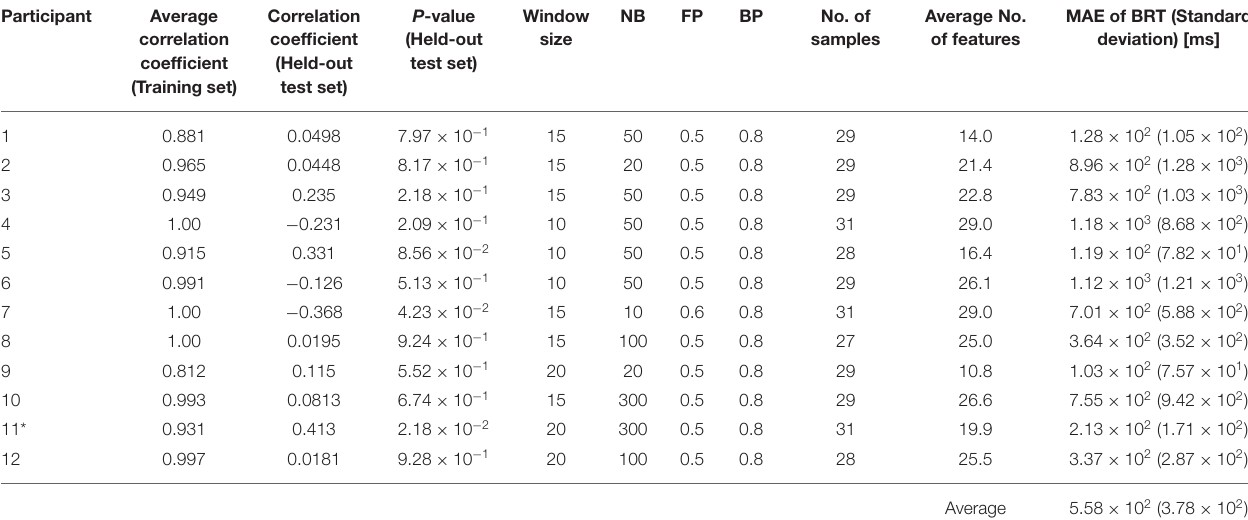
TABLE 1 | The performance and the optimized hyperparameters for the individual regression models ( * p < 0.05 on the test set). Participant Average correlation